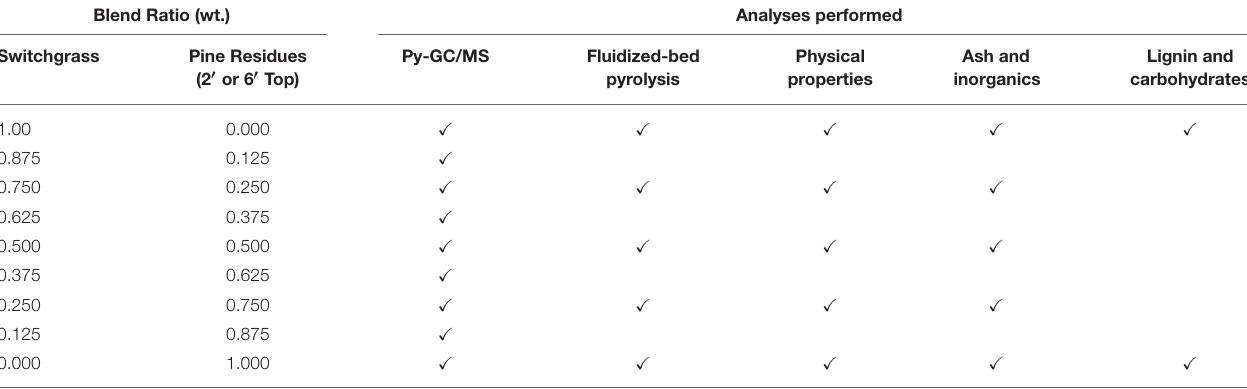
TABLE 1 | Weight ratios of prepared switchgrass/pine residues blends and associated analyses performed for each blend ratio. Blend Ratio (wt.)